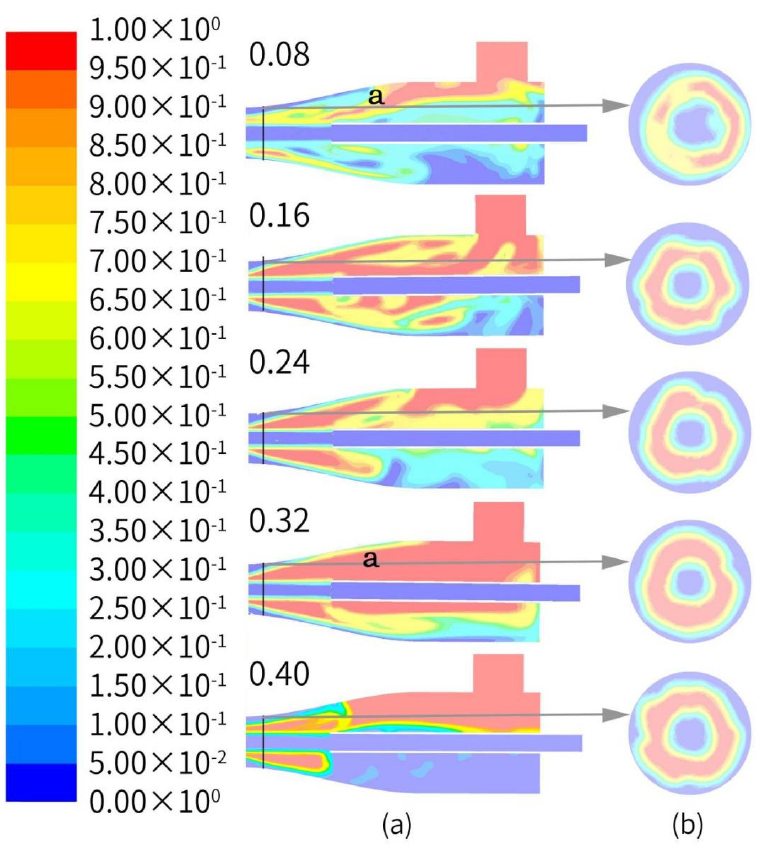
Figure 7. Distribution of gas volume fraction with different gas–liquid ratios. ( a ) Distribution of gas–phase volume fractions on plane Y = 0. ( b ) Distribution of gas–phase volume fractions on cross–section X = 0.065 m.